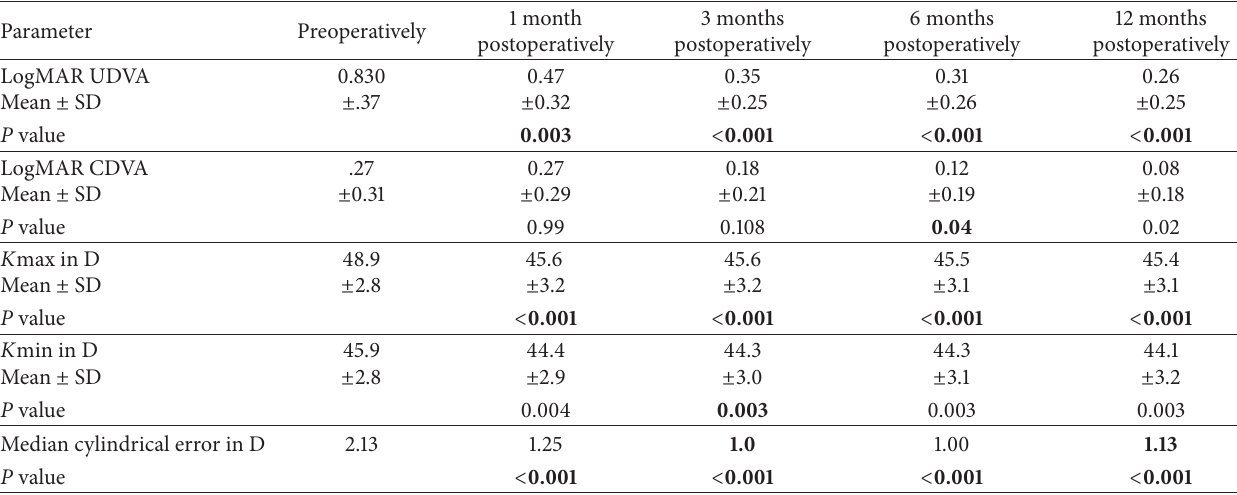
Table 1: Summary of results.